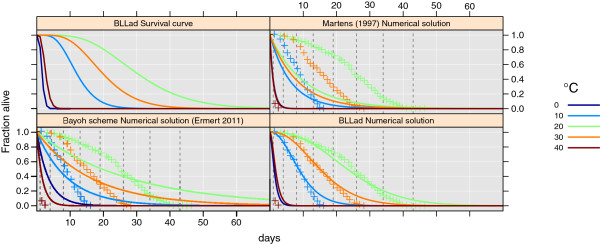
Proportion of An. gambiae s.s. surviving at 60% relative humidity and mean temperature of 0, 10, 20, 30, and 40°C (selected for clarity) according to time (in days). Dashed vertical lines indicate the different age groups in the model. The Survival curve panel shows Eq. 31, while the Numerical solution panel shows survival in the model when the age groups are split into nine classes. For reference we also show survival according to the Marten equation (27) and Eq. 7 from Ermert et al. (Bayoh scheme) [29]. The mean absolute error for all combinations of temperature and relative humidity was 73 for our model, 171 for the Marten model, and 129 for the Bayoh scheme.